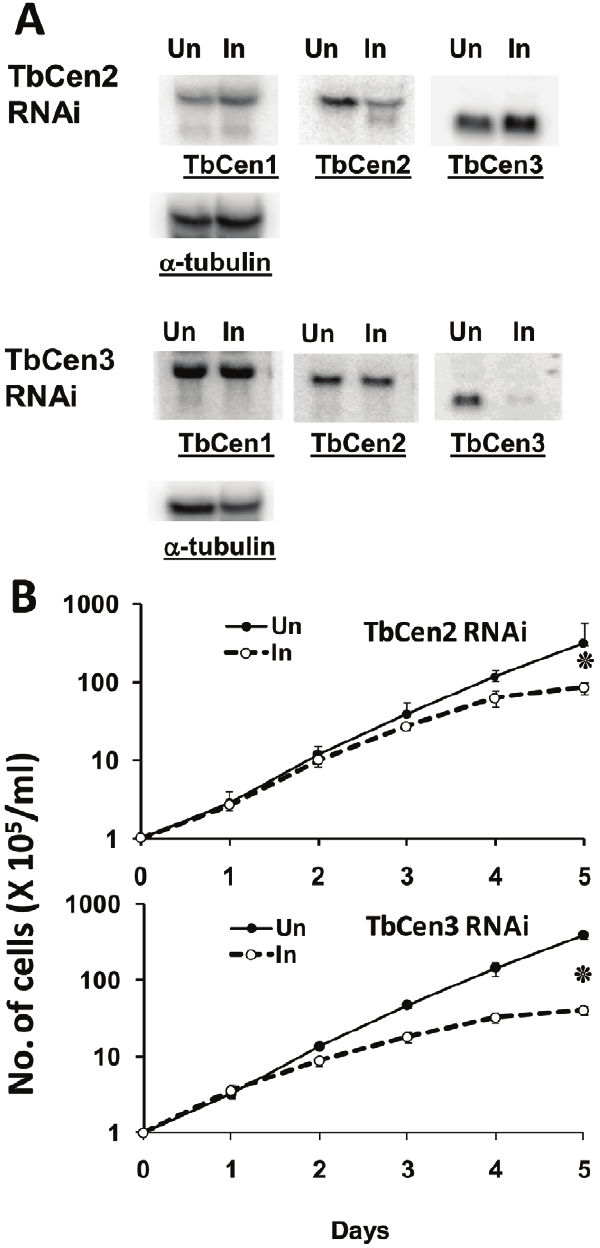
Figure 1. Centrins’ RNAi and their effect on parasite growth. A : Northern blots of RNA from induced (I) and uninduced (UN) TbCen2 and 3 cultures. Membranes containing 12 m g total RNA from day 2 uninduced and induced cells were used. Membranes, in addition to hybridization with DNA probes of either specific centrin or a -tubulin (loading control) were reprobed with DNA probes of other centrins (TbCen1-3). B : The effect of TbCen2 and 3 knockdown on the in vitro growth of T. brucei procyclics. The cells were grown with or without tetracycline. The data represent the means of 6 SD of the three independent experiments. *p ,